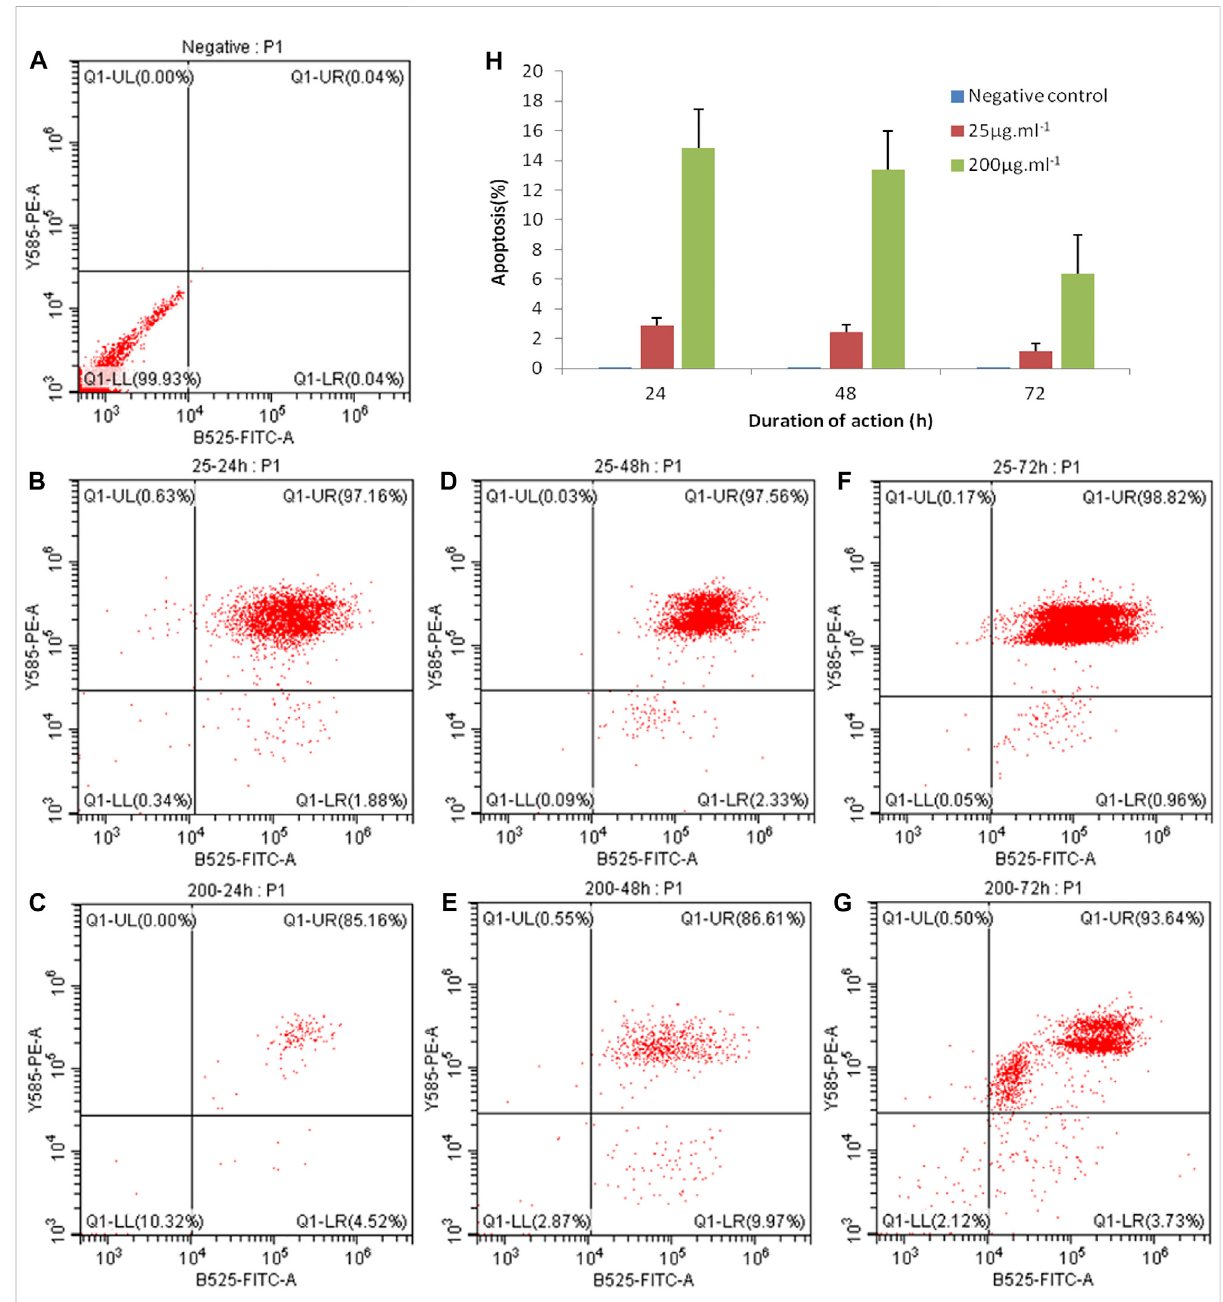
FIGURE 7 EBL cell apoptosis caused by ZnO nanosheet detection using FCM. (A) Negative control; (B) 25 μ g mL − 1 – 24 h; (C) 200 μ g ml − 1 – 24 h; (D) 25 μ g mL − 1 – 48 h; (E) 200 μ g ml − 1 – 48h; (F) 25 μ g ml − 1 – 72 h;and (G) 200 μ g ml − 1 – 72 h.Asshowninthe fi gure,theconcentrationsof25 μ g ml − 1 and 200 μ g ml − 1 of ZnO nanosheets were applied to EBL cells for 24, 48, and 72 h, respectively, and severe apoptosis was observed in each treatment group, which was signi fi cantly different from the control